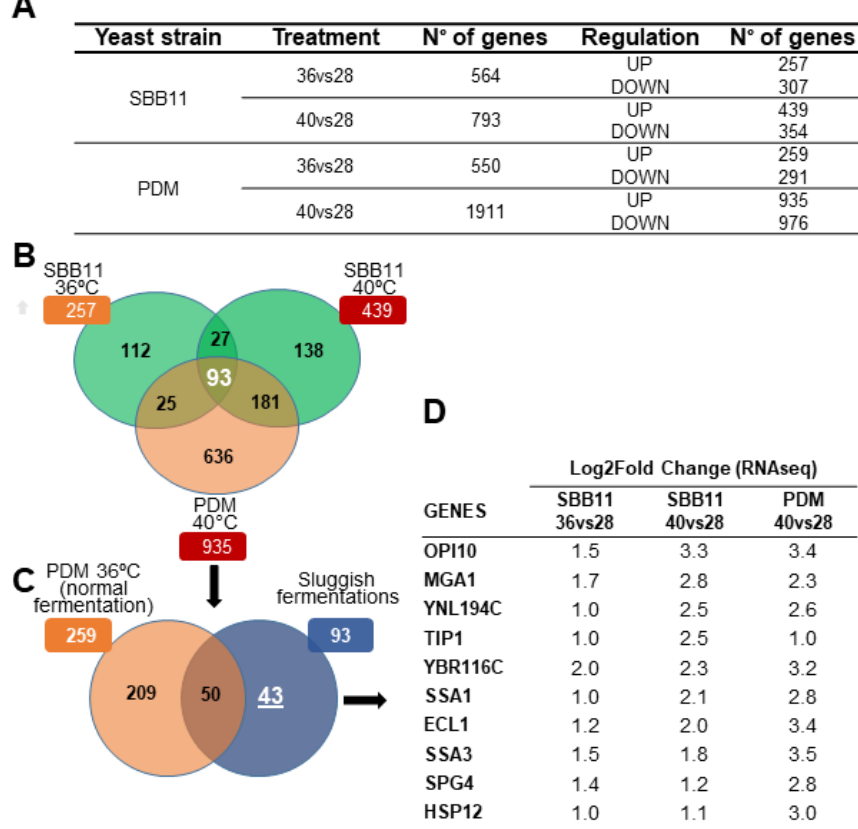
Figure 2. Candidate gene selection. Table A describes the number of differentially expressed genes in the two S. cerevisiae strains (SBB11 and PDM) subjected to heat shock at 36 and 40 ◦ C, showing the number of genes up- and downregulated ( A ). Venn diagrams show overlapping differentially expressed genes in the three treatments with sluggish fermentations ( B ). Venn diagrams show 93 previously selected genes overlapping with upregulated genes in fermentations subjected to heat shock without sluggish fermentation (PDM at 36 ◦ C) ( C ). List of the ten selected genes ( D ).